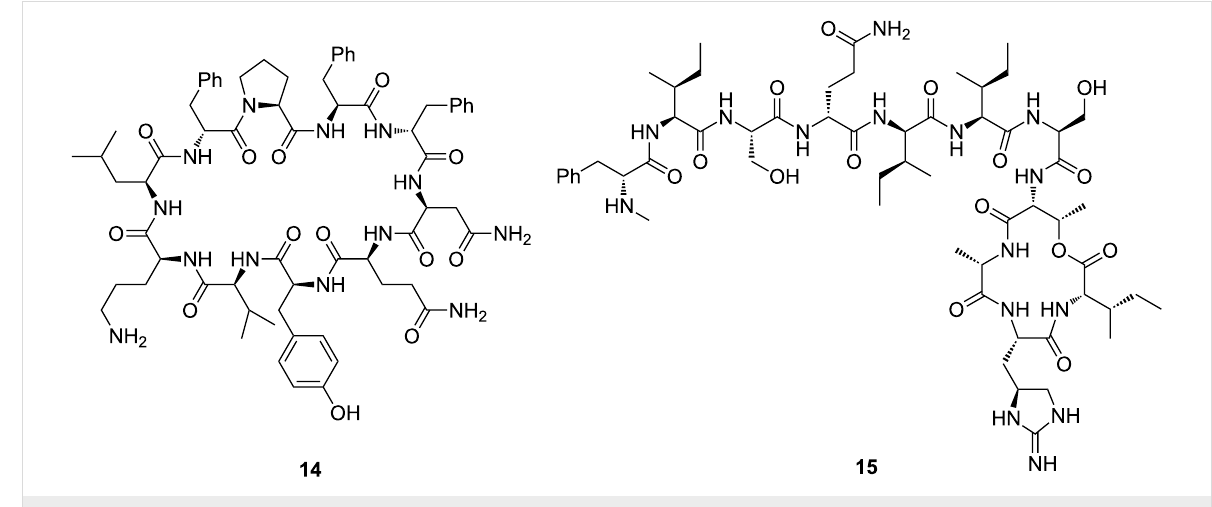
Figure 3: Structures of tyrocidine A ( 14 ) and teixobactin ( 15 ).